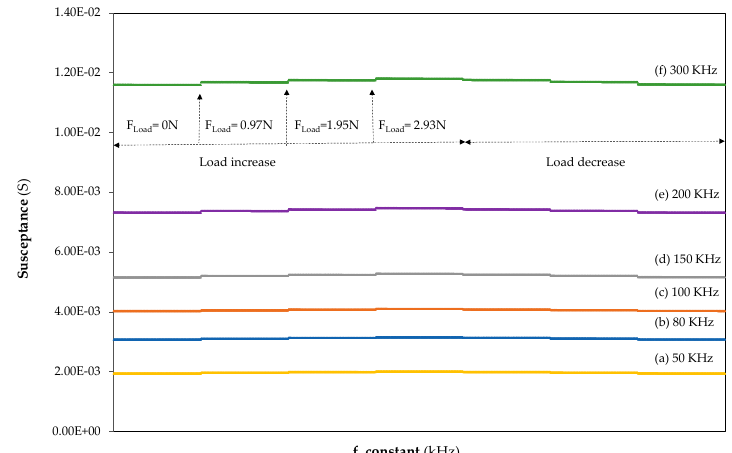
Figure 3. Loading and unloading variation of susceptance, absolute values at constant frequencies of ( a ) 50 kHz (yellow), ( b ) 80 kHz (blue), ( c ) 100 kHz (orange), ( d ) 150 kHz (grey), ( e ) 200 kHz (purple) and ( f ) 300 kHz (green) in the aluminium sample with h = 3 mm.